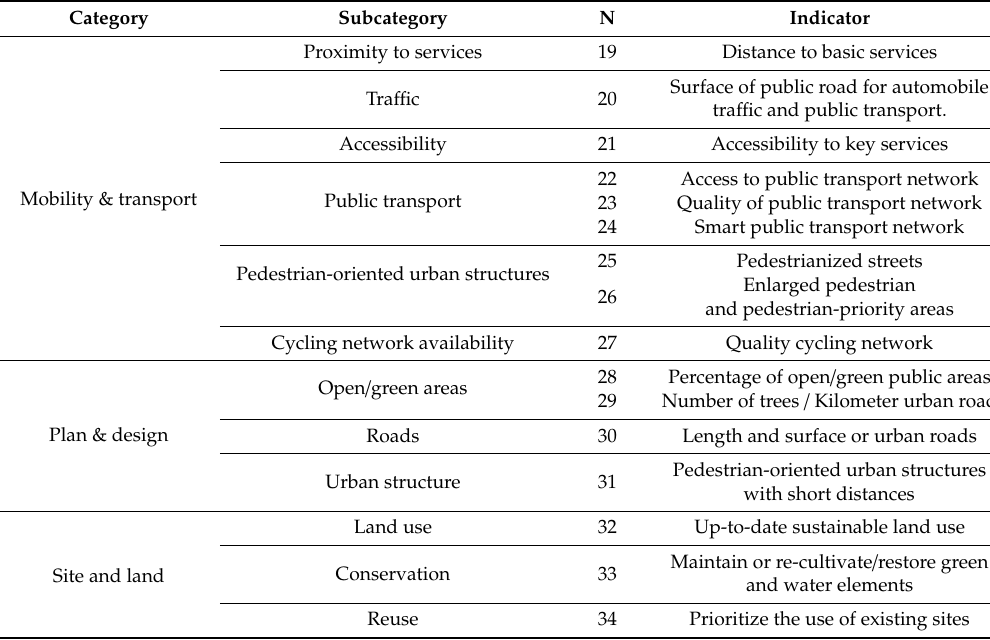
Table 4. Proposed indicators for environmental aspects (territory management